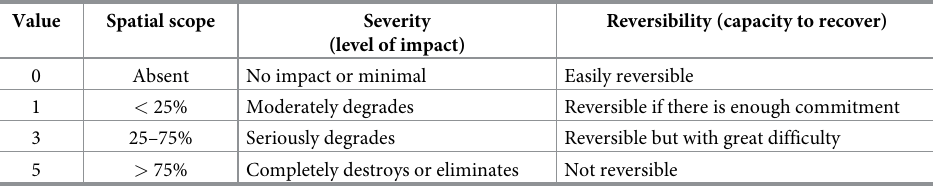
Table 2. Criteria used for ranking spatial scope, severity and reversibility in the threat-ranking exercise (cid:3) . Value Spatial scope Severity Reversibility (capacity to recover) (level of impact) 0 Absent No impact or minimal Easily reversible < 25% Moderately degrades Reversible if there is enough commitment 3 25–75% Seriously degrades Reversible but with great difficulty